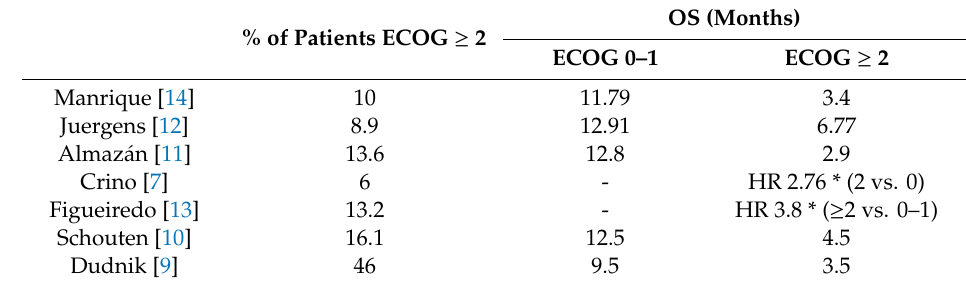
Table 3. Prognostic value of performance status in patients treated with nivolumab—real-world